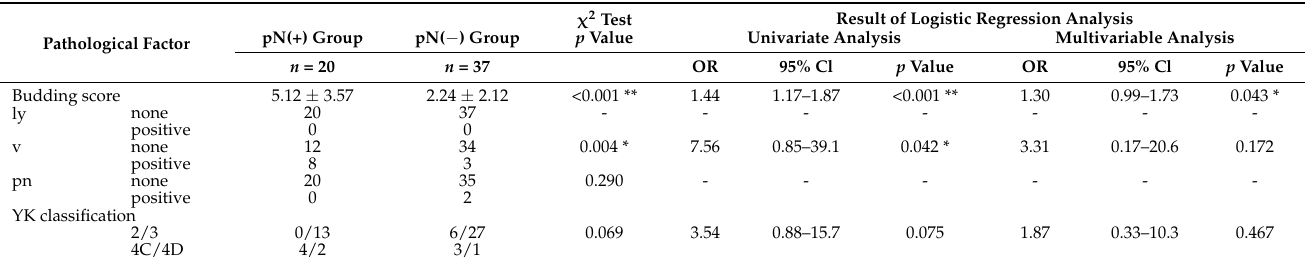
Table 3. Pathological factors related to lymph node metastasis. Logistic regression analysis for pathological factors predicting lymph node